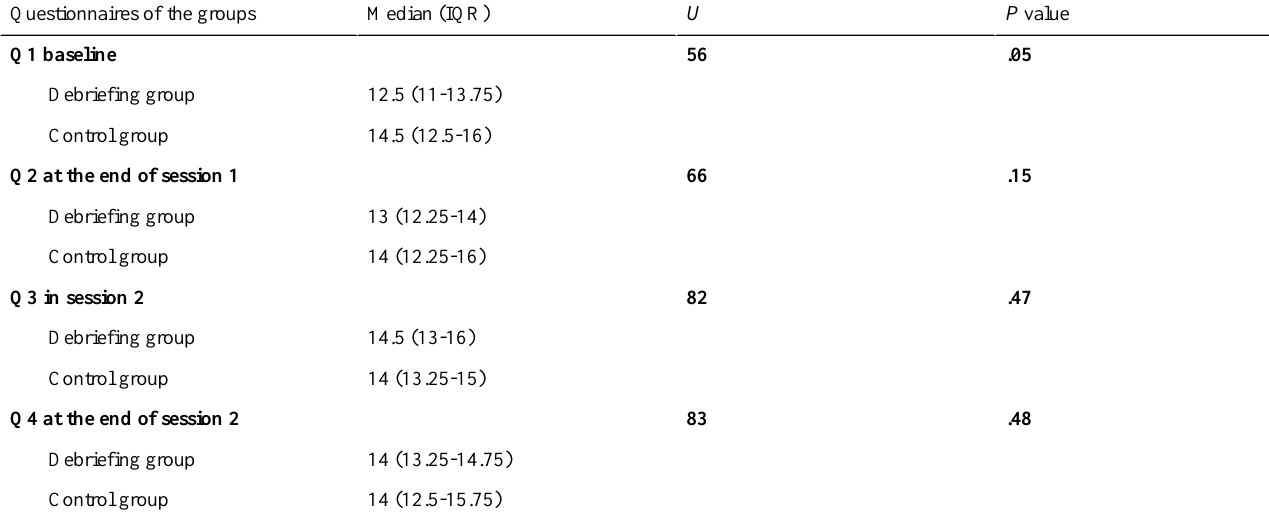
Table 1. Comparison of the knowledge questionnaires of the control and debriefing groups.